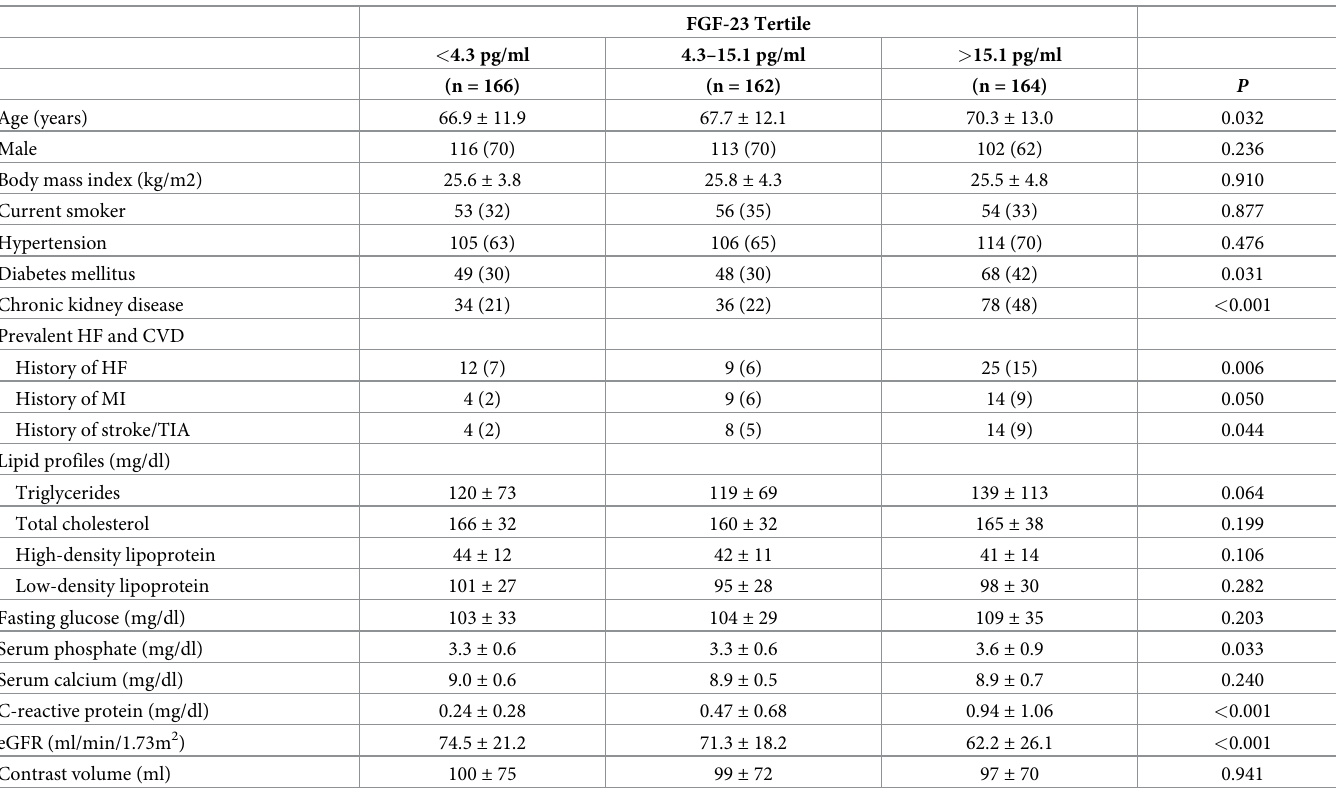
Table 1. Baseline characteristics of the study population by tertiles of